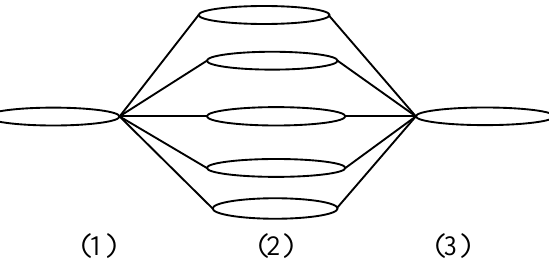
Figure 6. Architecture of the back propagation neural network. Ellipses correspond to neurons and lines represent the interconnection between them. ( 1 ) Input layer, ( 2 ) Hidden layer and ( 3 ) Output